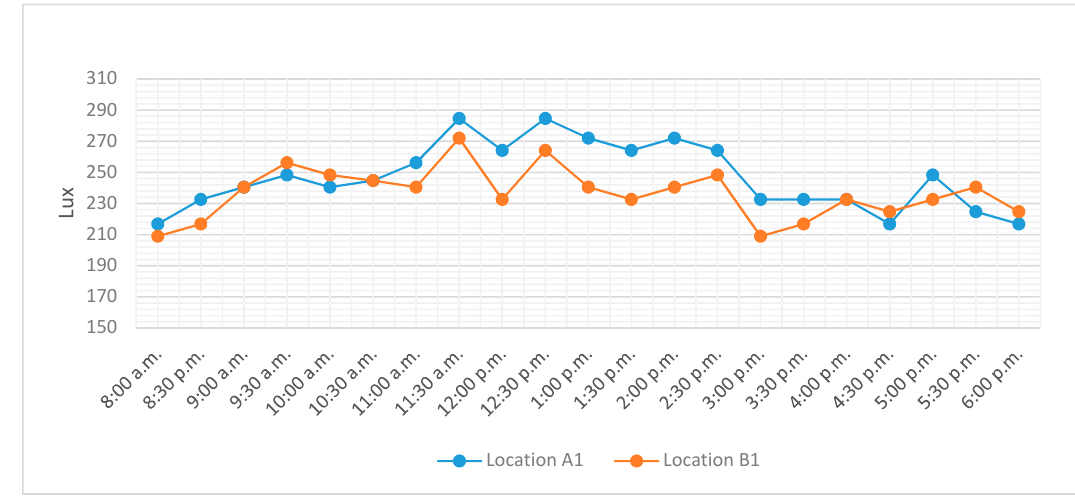
Figure 13. Indoor light intensity in the lobby of Building A (Location A1) and Building B (Location B1).